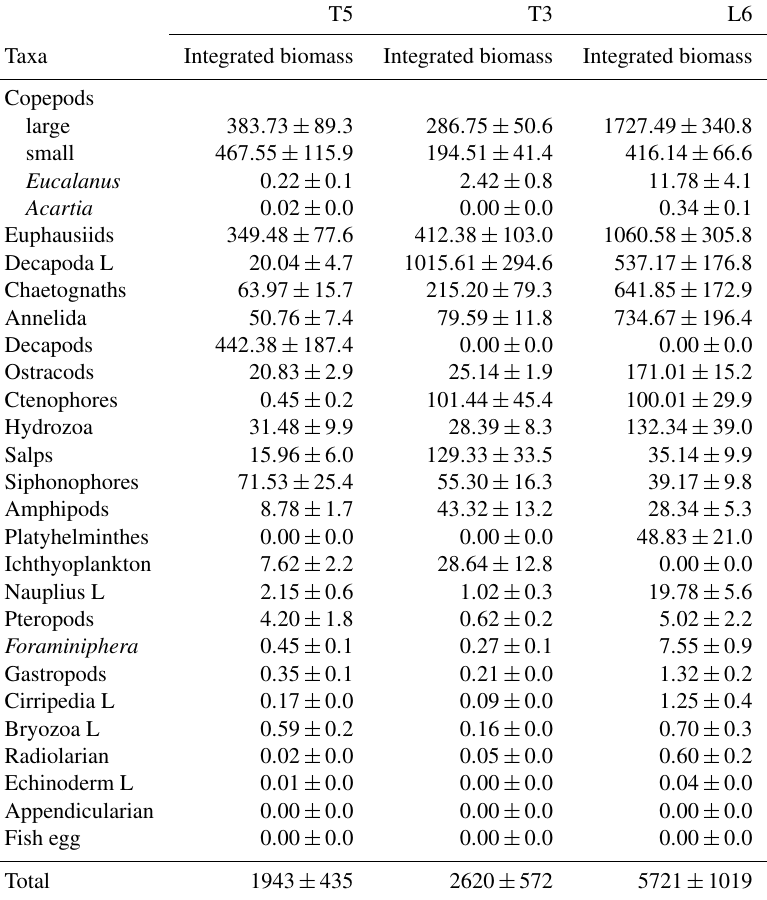
Table 2. Mean and standard deviation ( ± ) of integrated biomass (mg Cm − 2 ) by taxonomic groups identified and sorted by ZooScan during daytime and nighttime conditions at three stations (T5, T3 and L6) sampled off northern Chile, during the austral spring 2015. Mean ± SD are from n = 8 for Stations T5 and T3, and n = 4 for Station